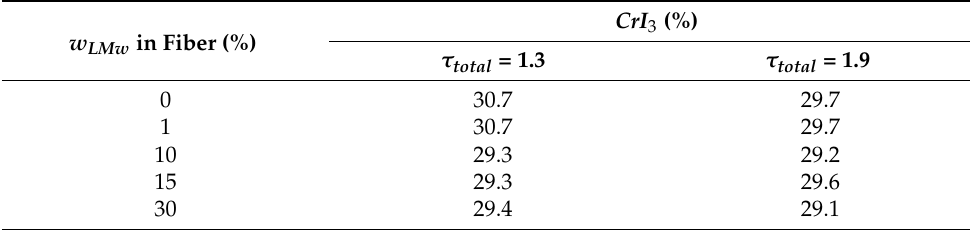
Table 3. Crystallinity index ( CrI 3 ) of spun fibers with increasing LMW chitosan contents, at stretching ratios τ total of 1.3 and